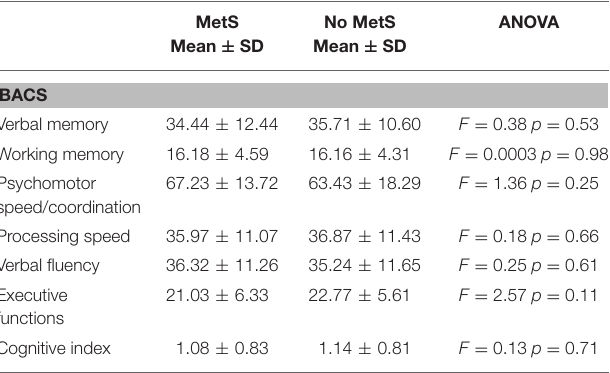
TABLE 2 | Cognitive measures (Brief Assessment of Cognition in Schizophrenia-BACS adjusted scores) in patients stratified by metabolic syndrome’s diagnosis.